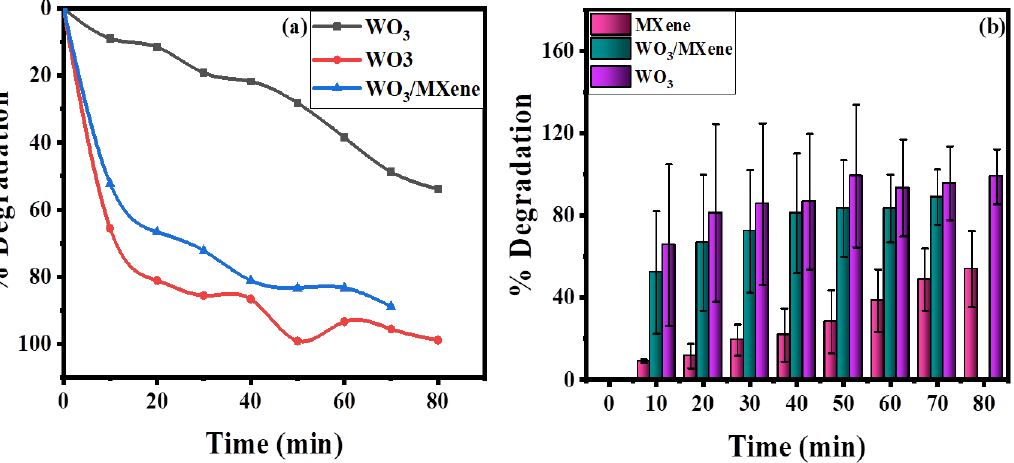
Figure 10. ( a ) Comparison of photocatalytic degradation of methylene blue by WO 3 , MXene, and WO 3 /Mxene ( b ) bar chart representation of percentage degradation with error bars.